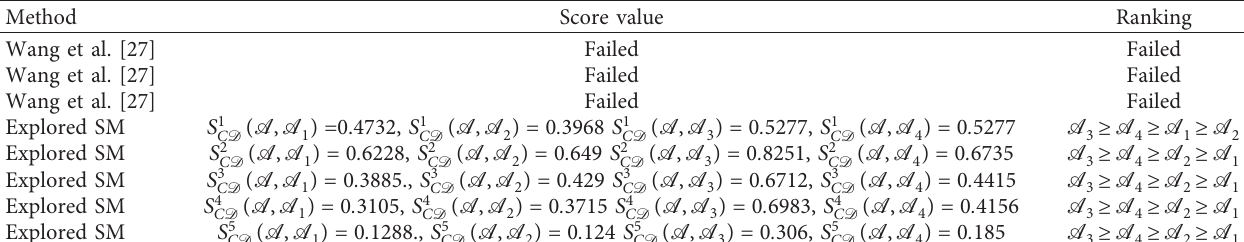
, ϕ ) � ( 0 . 5 , 0 . 5 ) . cc cc